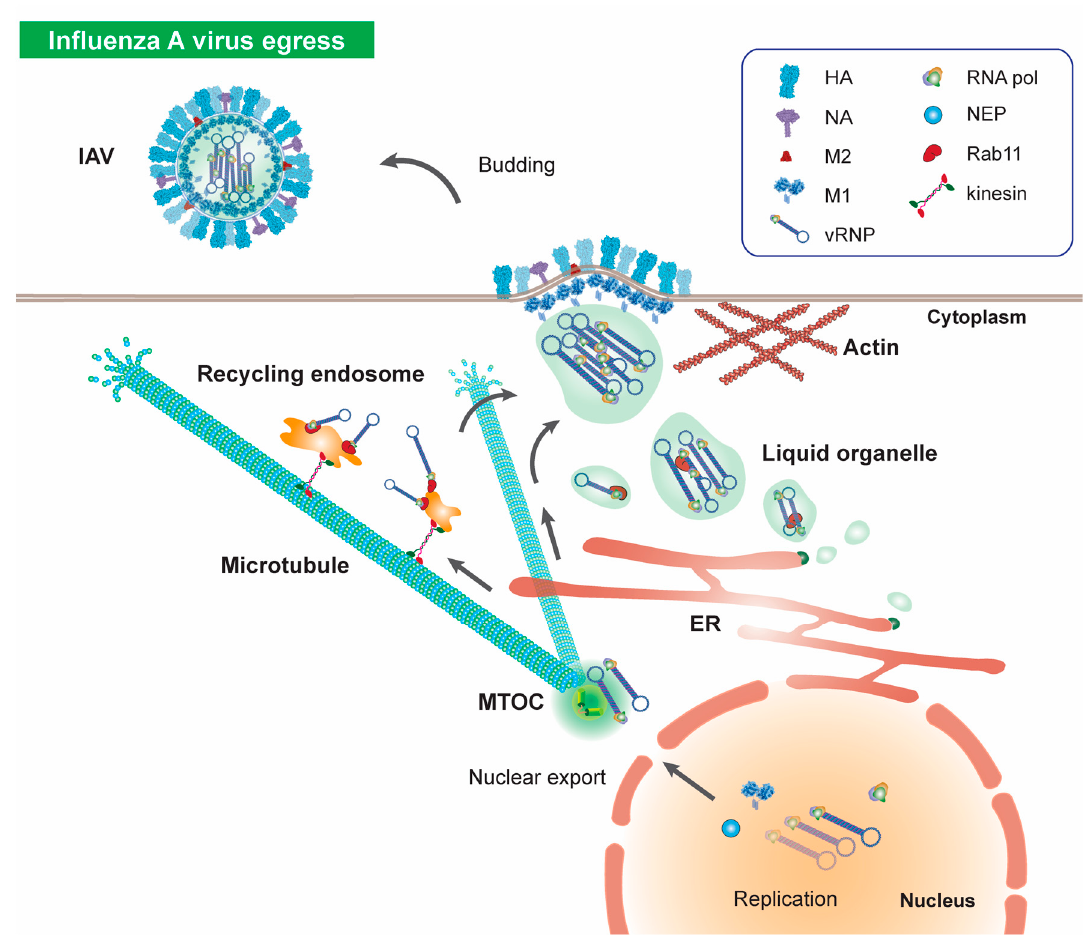
Figure 3. Influenza A virus egress. Following replication of viral RNA, newly synthesised vRNPs are exported from the nucleus and accumulate at the MTOC, before trafficking towards the cellular periphery in a microtubule dependent manner for assembly and budding. Influenza viruses utilise components of the endocytic recycling and secretory pathways for apical transport; associations between Rab11-positive recycling endocytic vesicles and influenza viruses allow viral traffic along microtubules. In addition, vRNPs induce formation of liquid organelles which associate with Rab11 for vRNP traffic via the secretory pathway. Following microtubule-dependent anterograde traffic to the cellular periphery, vRNPs assemble to form new virions and bud from the cell surface to trigger secondary infection in permissive cells. Three-dimensional structural data: PDB ID HA (2IBX); NA (6CRD); M2 (3BKD); M1 (1EA3) [65] .